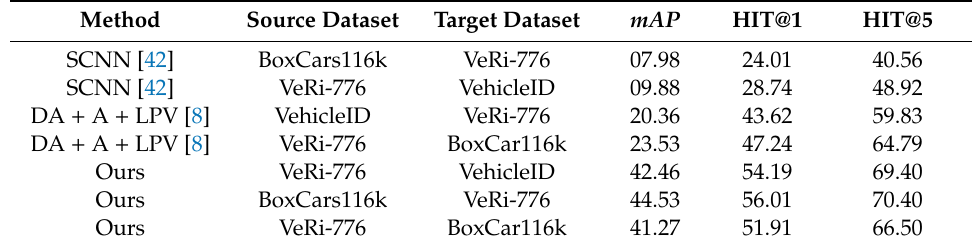
Table 5. Cross-dataset vehicle Re-Id results on di ff erent datasets and comparison with other